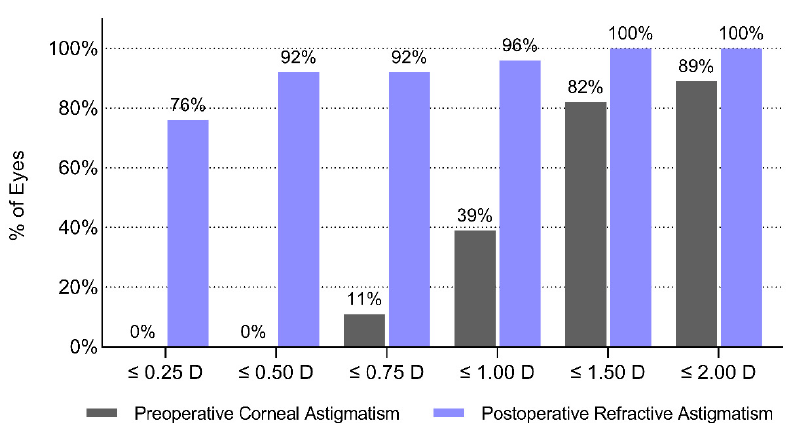
Figure 2. Cumulative histogram of preoperative corneal and postoperative refractive astigmatism measured one year postoperatively at the corneal plane.